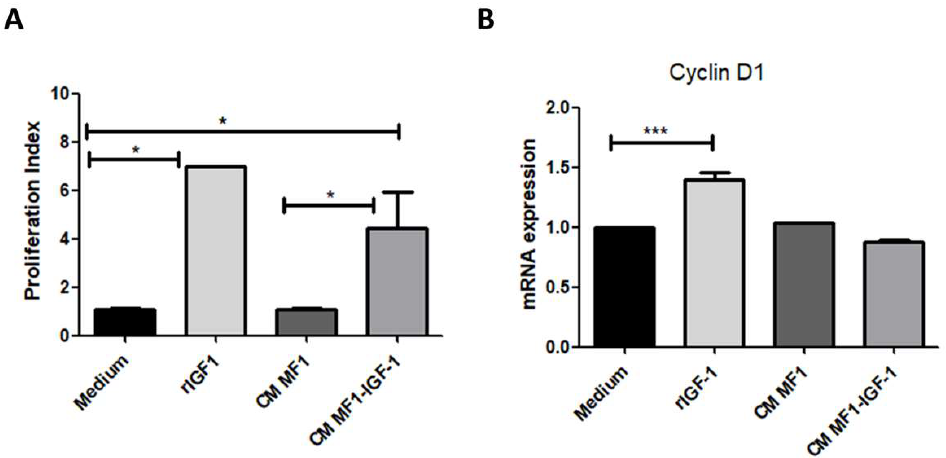
Figure3. Figure 3. Cell proliferation analysis after stimulation of SCC-4 cells with IGF-1 or fibroblast- conditioned media. Control medium, rIGF-1, CM MF1 or CM MF1-IGF1 was used to stimulate SCC-